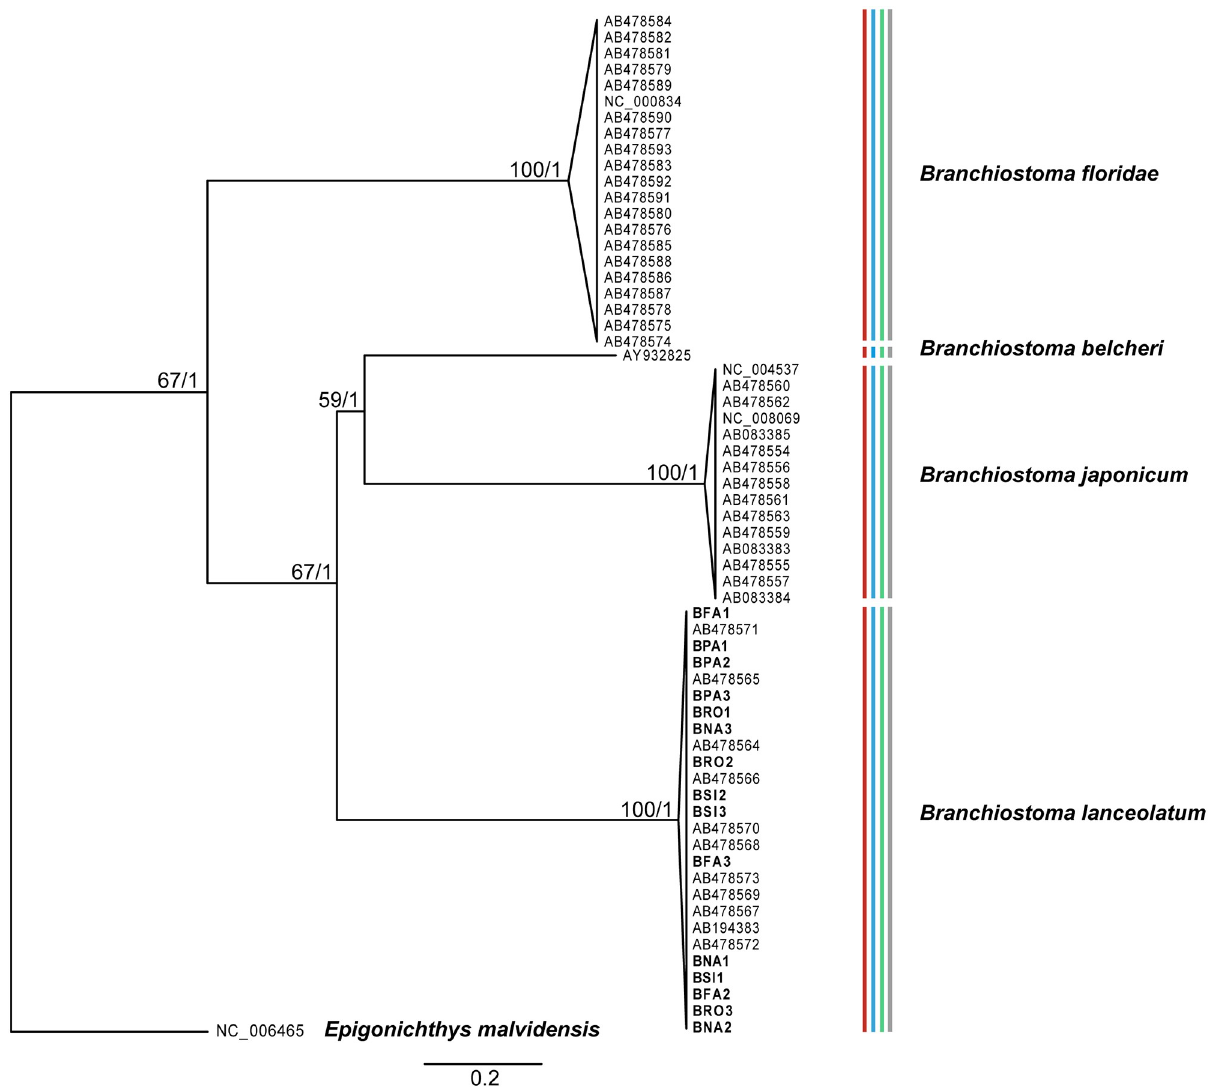
Fig 2. ML and BI consensus tree based on the analyses of the concatenated mitochondrial dataset (COX1+12S+16S). Values at nodes represent ML bootstrap support and Bayesian posterior probabilities, respectively. Colored bars indicate the results of the species delimitation analyses: bPTP with ML tree in red, bPTP with Bayesian tree in blue, ABGD in green, and TCS in grey. Novel sequence samples are highlighted in bold (see S1 Table for codes).